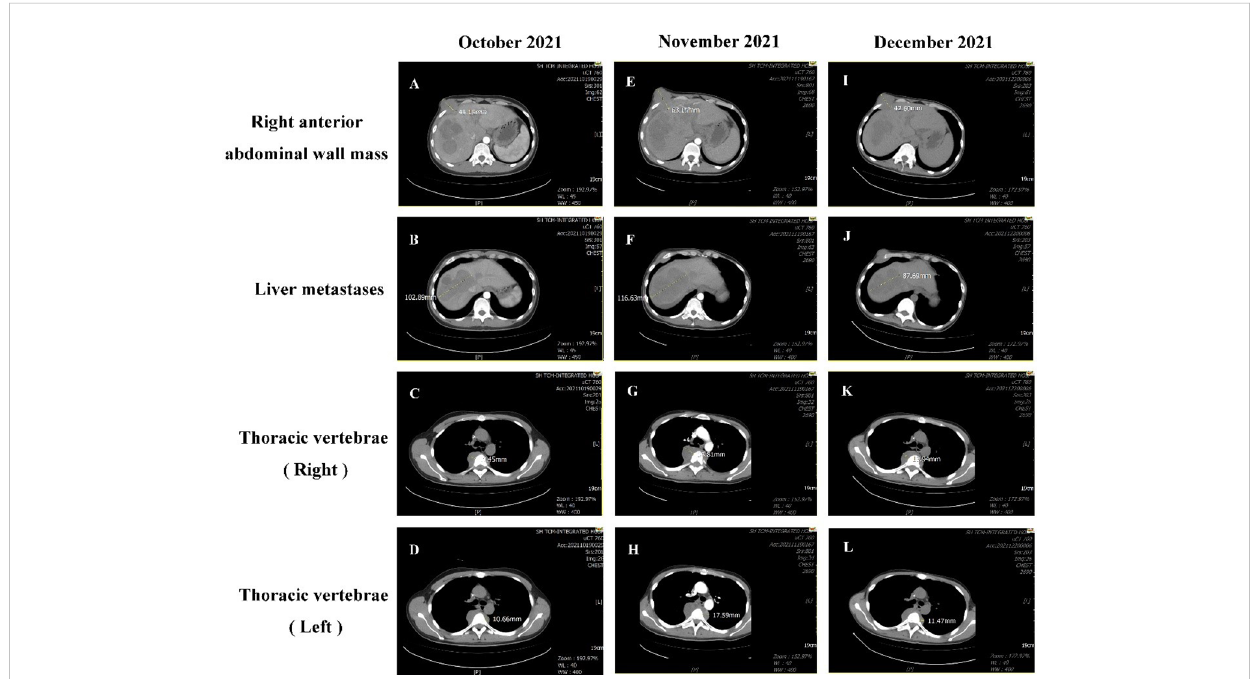
FIGURE 4 Comparison of CT results before and after treatment. On October 19, 2021, CT showed the following: (A) There was a right anterior abdominal wall mass approximately 45.15 mm in size. (B) Multiple intrahepatic masses were signi fi cantly enlarged and fused into a mass, with the maximum diameter of about 102.89mm. (C) The T5 soft tissue mass on the right side of the vertebral body approximately 19.45 mm in size. (D) The size of the T4-6 vertebrae metastasis on the left was approximately 10.66mm. On November 19, 2021, CT showed the following: (E) the right anterior abdominal wall mass had grown to 63.15 mm. (F) The size of the liver metastasis increased to 116.63 mm. (G) The T5 soft tissue mass on the right side of the vertebral body had increased to 33.81mm. (H) The mass on the left side of the T4-6 vertebrae was approximately 17.59mm. On December 21, 2021, CT showed the following: (I) The right anterior abdominal wall mass had decreased in size to 42.60 mm. (J) The sizes of the multiple masses in the liver were reduced to 87.69 mm. (K) The soft tissue mass surrounding the T5 vertebrae was 19.94 mm. (L) The mass on the left side of the T4-6 vertebrae was approximately 11.47